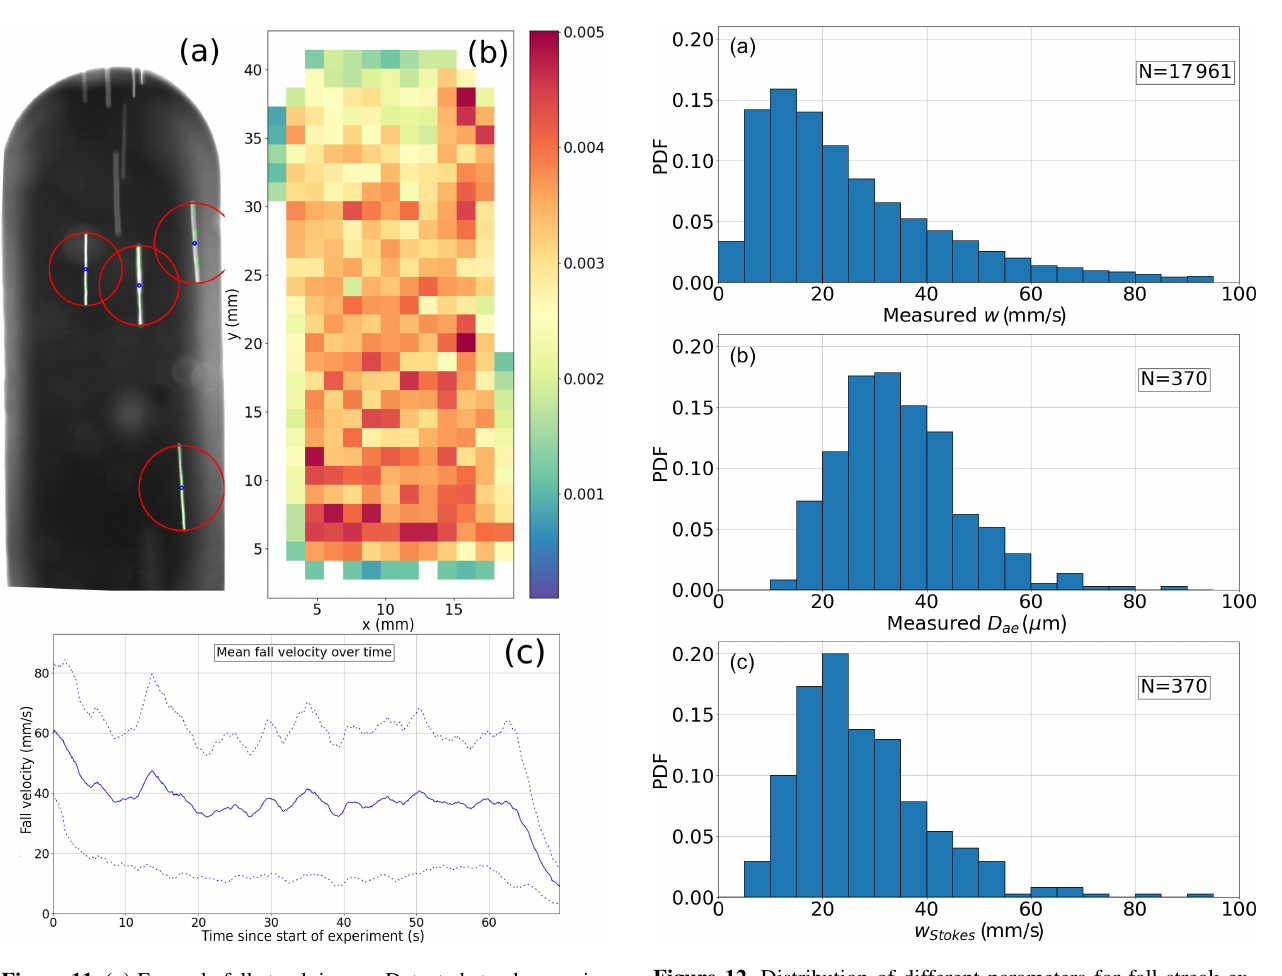
Figure 11. (a) Example fall streak image. Detected streaks are cir- cled in red, diameter is equal to the detected streak length. (b) Rel- ative occurrence of crystals in partial regions of the sample volume, number of streak center points observed in pixel region divided by number of streaks in the full image. Total number of streaks in ex- periment: N = 24775. (c) Mean velocity of all falling objects in the sample volume over time. A moving average over 2s was used to smooth the time series. The dashed lines show the moving average of the fall speeds’ standard deviation in each image.